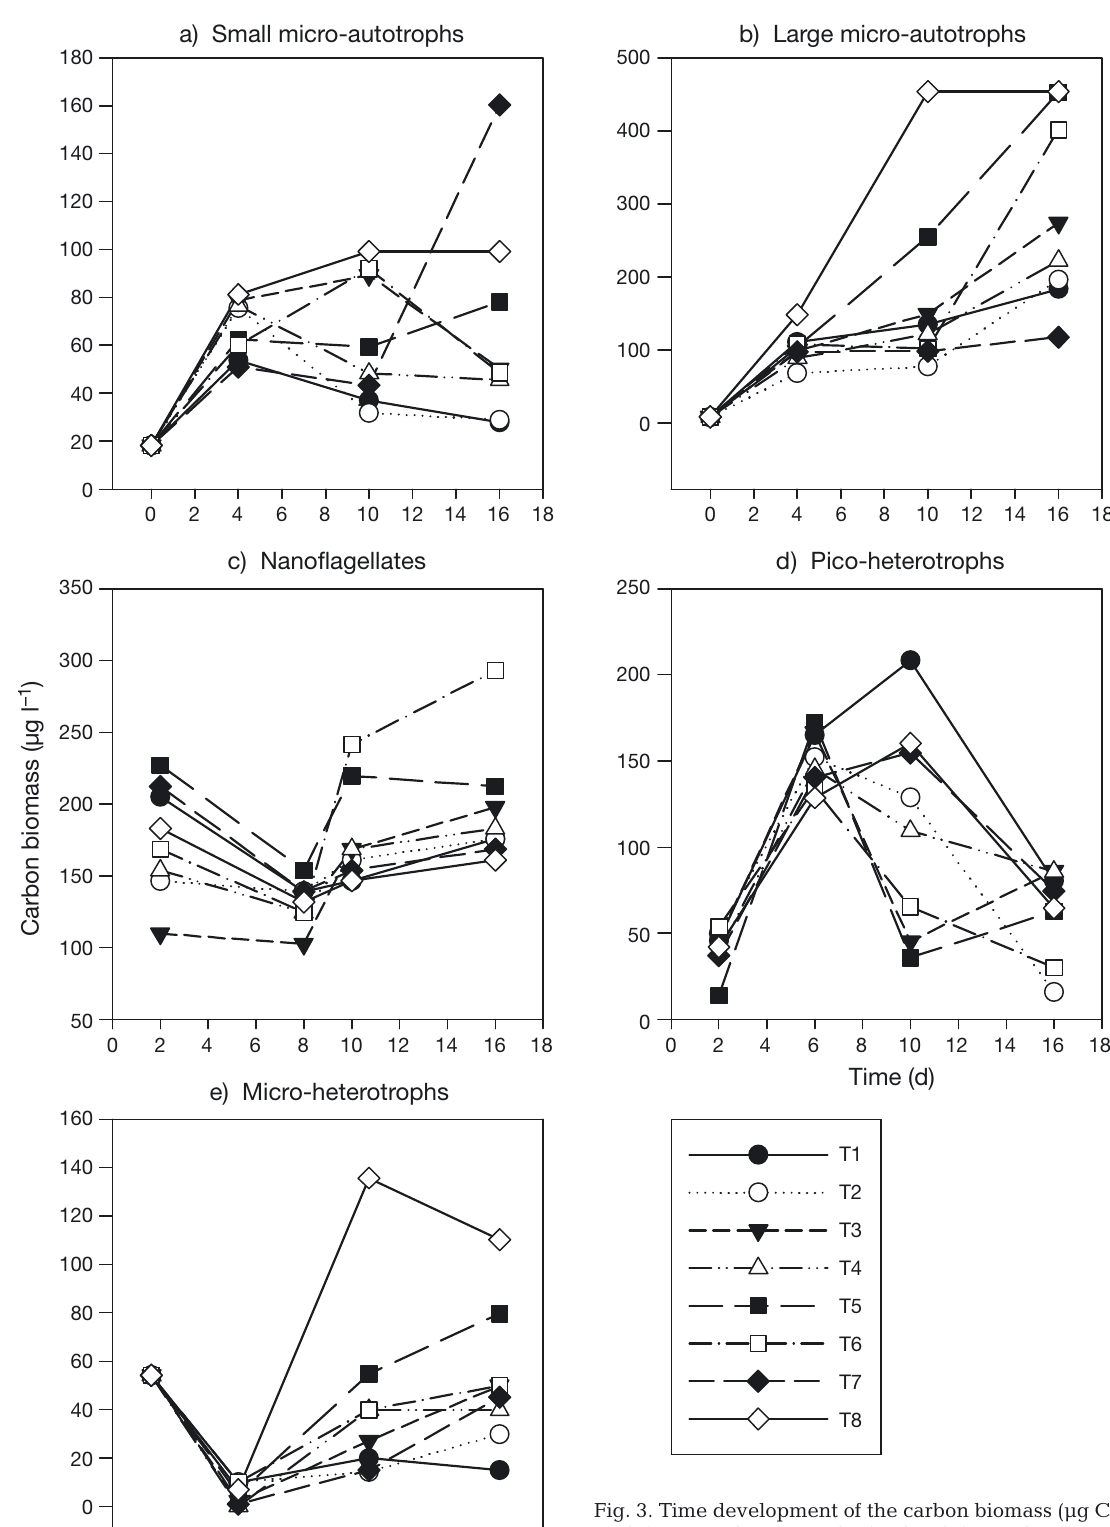
Fig. 3. Time development of the carbon biomass (µg C l −1 ) of each functional group in the food web for each experimental treatment (T1−T8, see Table 1): (a) small micro-autotrophs, (b) large micro-autotrophs, (c) nanoflagellates, (d) pico- heterotrophs, (e)